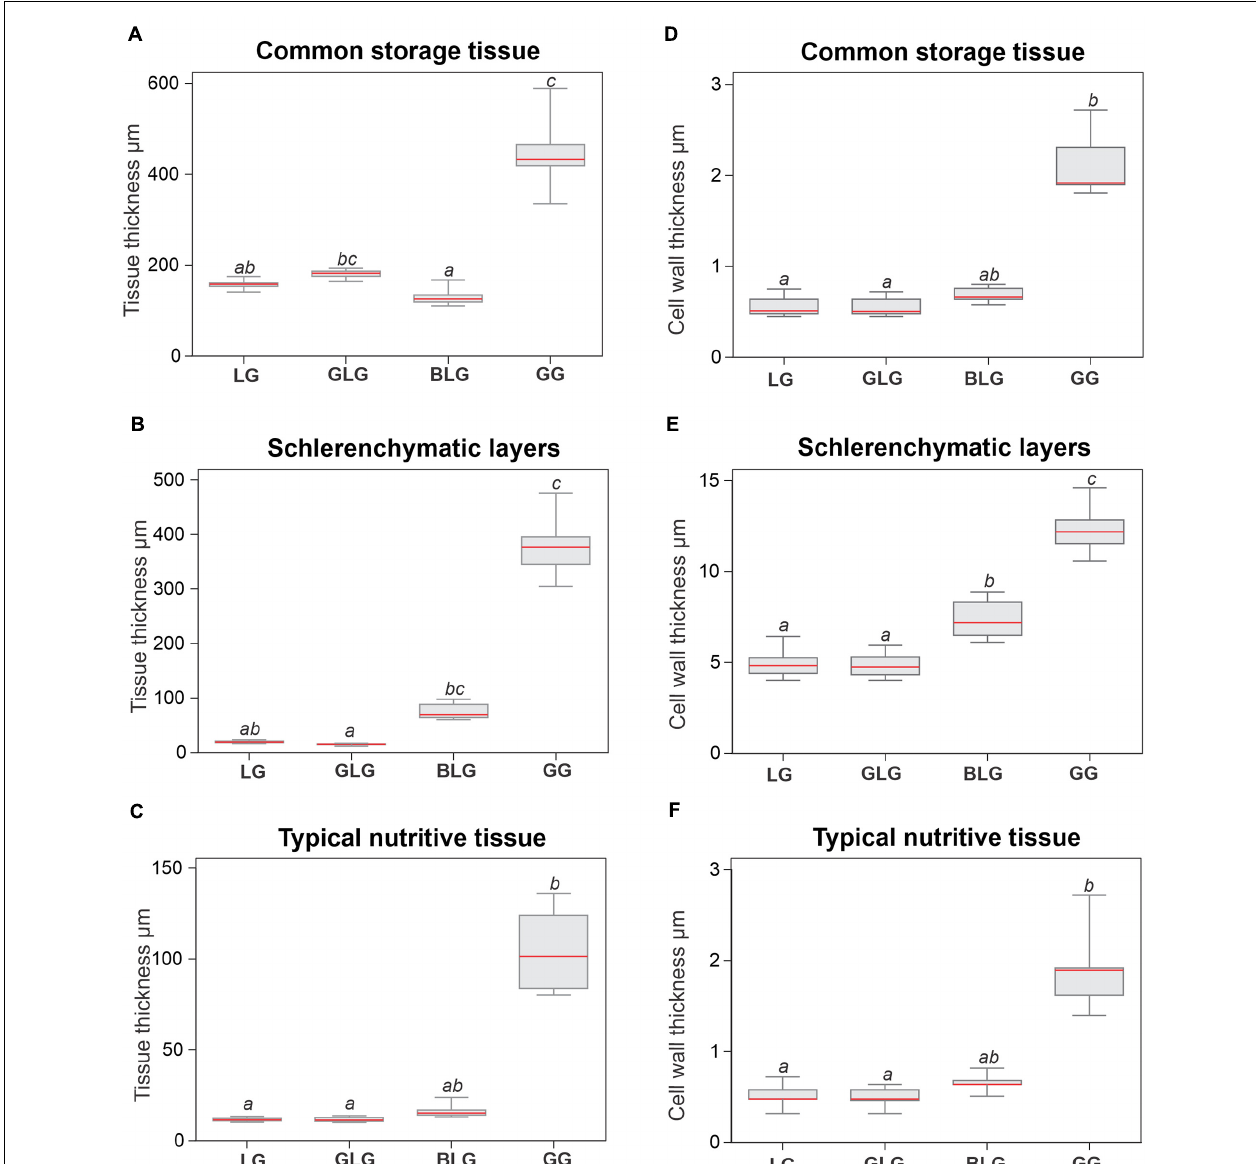
FIGURE 3 | Histometry of the tissues and cell walls of the four Lopesia galls on Mimosa gemmulata Barneby (Fabaceae) pinna-rachis (A–C) Tissue thickness. (D–F) Cell wall thickness. BLG, brown lanceolate bivalve-shaped gall, GG, globoid bivalve-shaped gall, GLG, green lanceolate bivalve-shaped gall, LG, lenticular bivalve-shaped gall. n = 5 per gall systems (5 regions per section from 1 sections); p < 0.05. Same letters on bars indicate statistically equal values for the same variable, and different letters indicate different values.